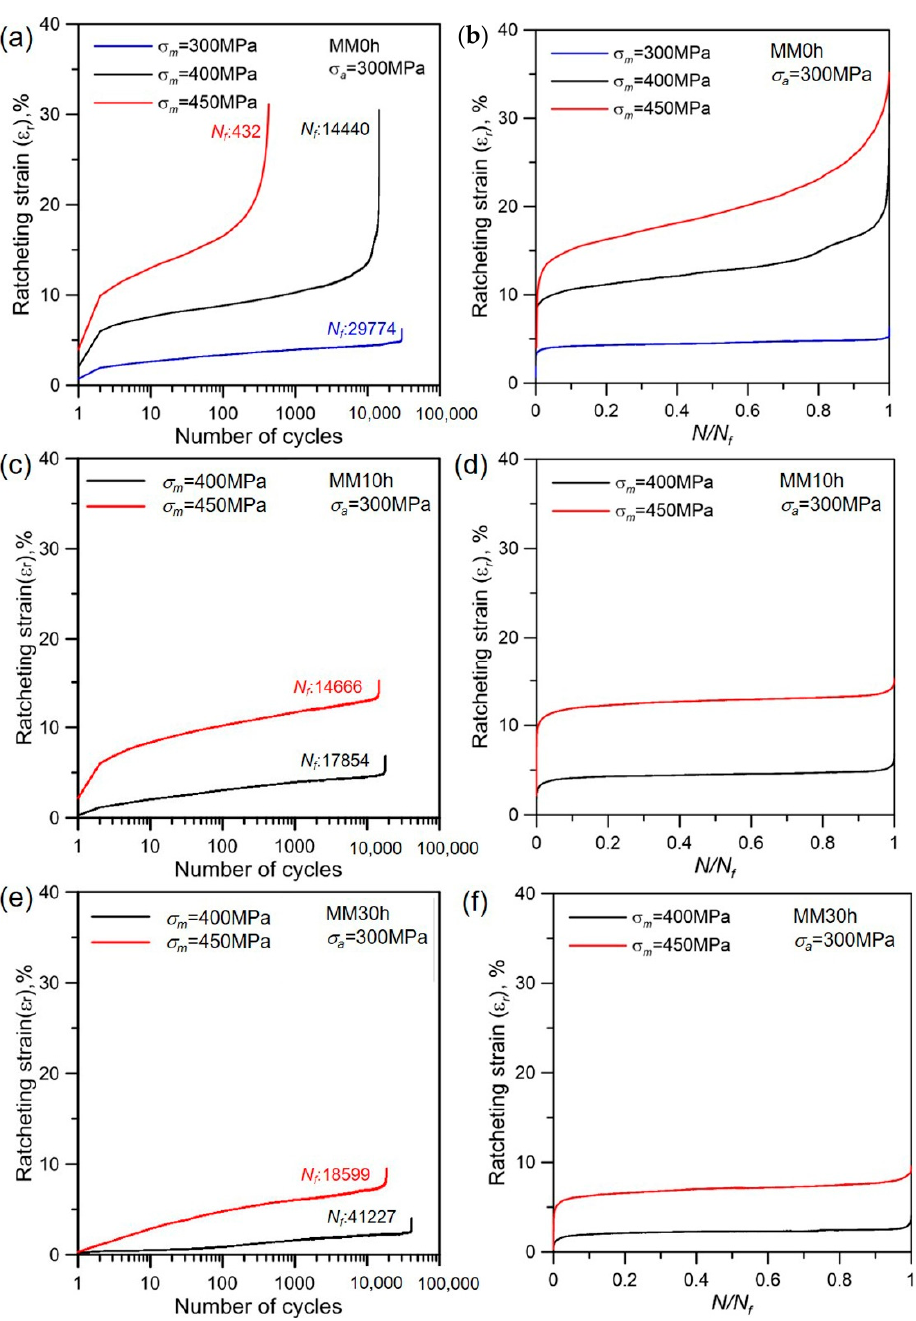
Figure 6. Effects of mean stress on fatigue life ( a , c , e ) and ratcheting strain ( b , d , f ) of harmonic-structured SUS316L steels: ( a , b ) MM0h compacts; ( c , d ) MM10h compacts; ( e , f ) MM30h compacts.